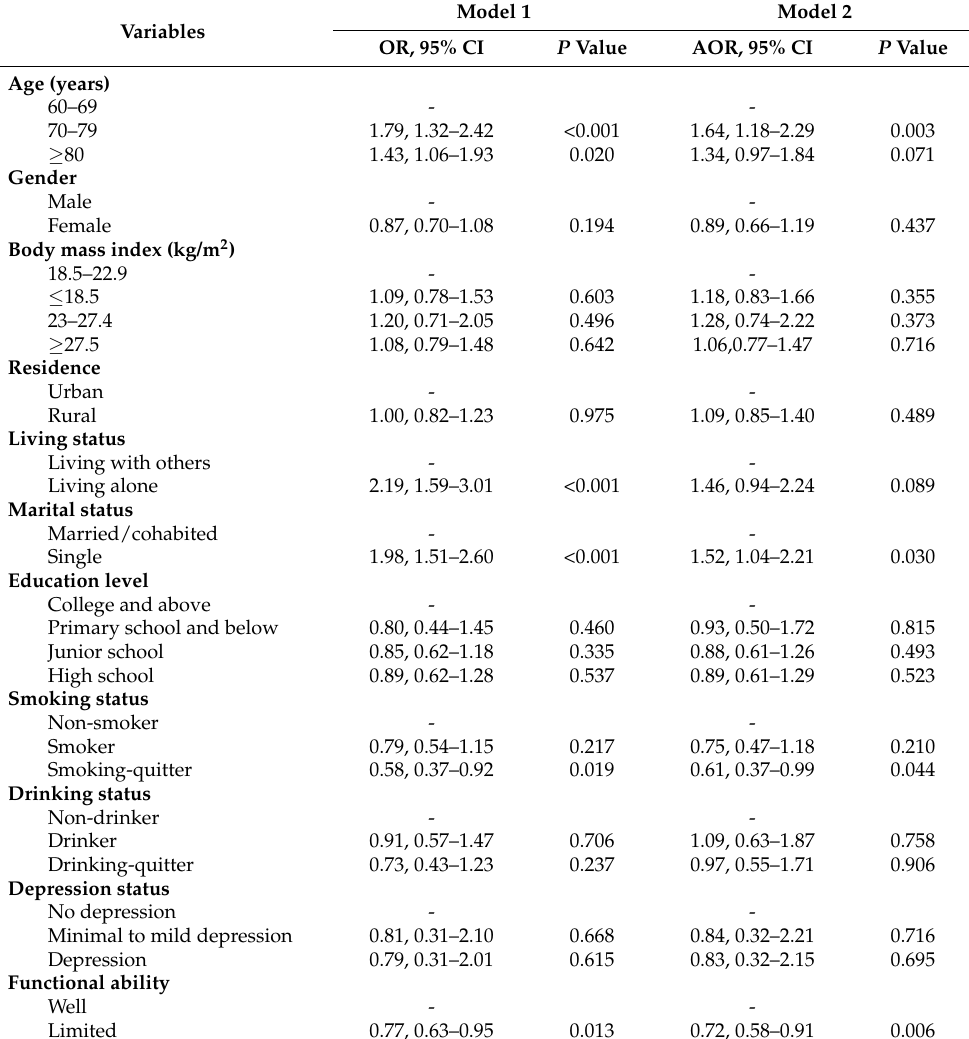
Table 2. Logistic regression analysis examining the correlation of medication adherence in pre-frail older adults ( n =